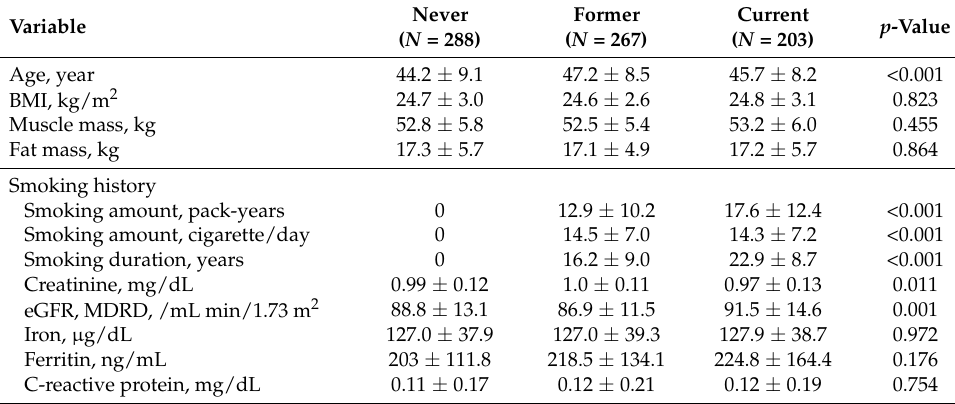
Table 1. Baseline characteristics of the study